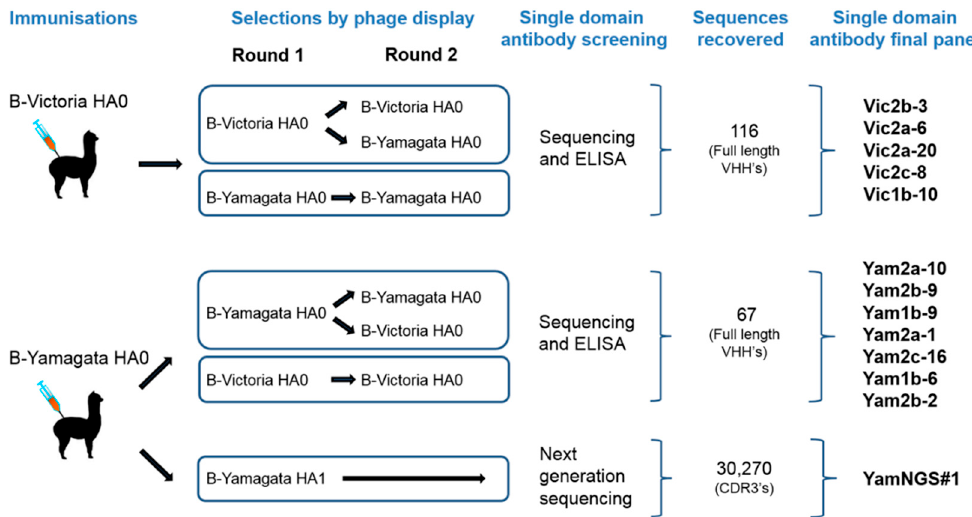
Figure 1. Selection strategies to isolate cross-reactive and lineage-specific single domain antibodies (sdAbs) against influenza B hemagglutinin. The figure shows the immunisation approaches, selection and screening strategies. The number of VHH CDR3 sequences isolated from each approach is indicated.